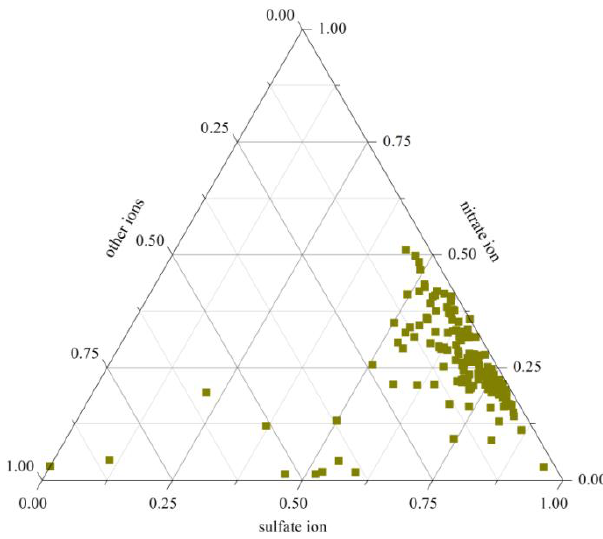
Fig. 8. The percent of main anions in